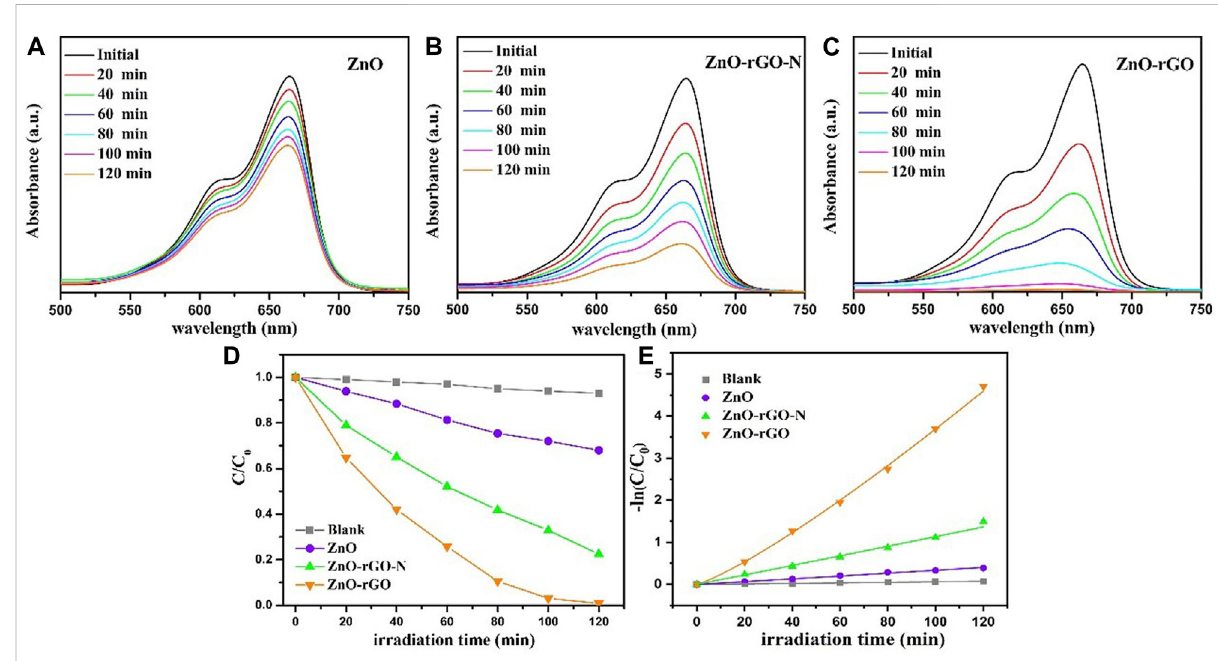
FIGURE 5 The changes of UV-vis spectra of dye degraded by ZnO (A) , ZnO-rGO-N (B) and ZnO-rGO (C) composites as interval illumination times, variation ratios of the concentrations of the MB degraded by different catalysts versus irradiation time (D) , and the corresponding kinetic curves (E)